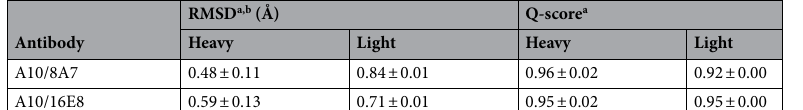
Table 3. Mean RMSD and Q-score for structural superposition between mA10 and each of two humanized A10 antibodies A10/8A7 and A10/16E8. a The values of RMSD and Q-score were calculated using UCSF Chimera by superimposing the 100 pairs of the top 10 predicted structures of mA10 and each humanized A10 antibody. b Abbreviation: RMSD, root mean square deviation.